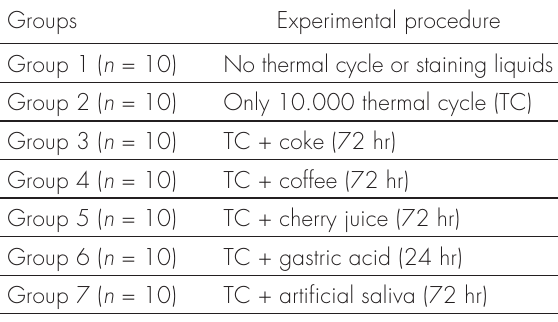
Table I. Definition of the